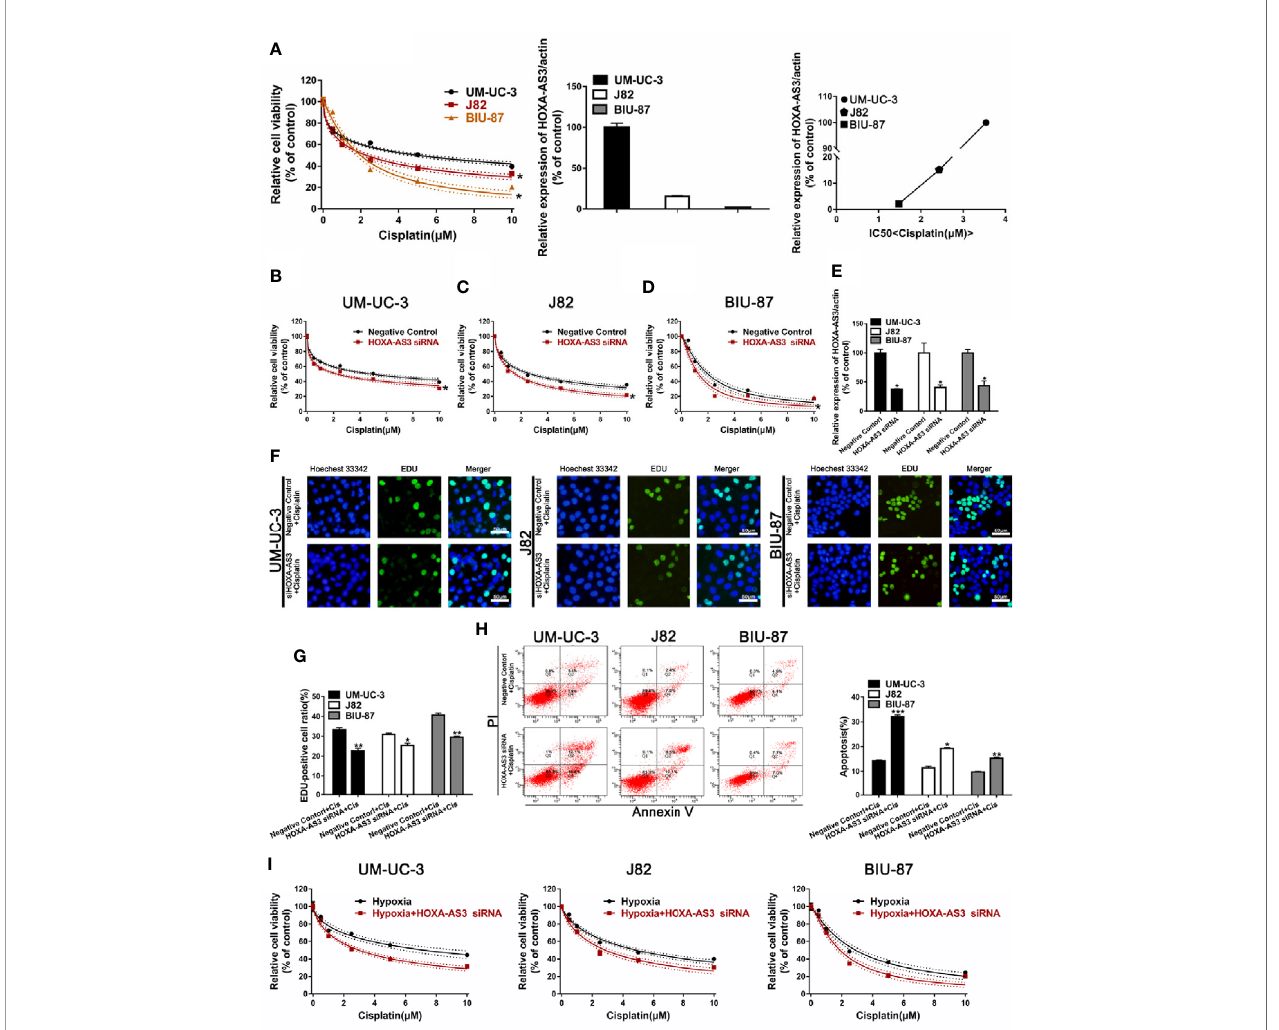
FIGURE 2 | Downregulation of HOXA-AS3 enhances cisplatin sensitivity. (A) Quantitative RT-PCR analysis of HOXA-AS3 levels in three bladder cancer cell lines. Cell viability (CCK-8) analysis of bladder cancer cells treated with various concentrations of cisplatin *P < 0.05 vs . UM-UC-3. Correlation curve showing the association of the expression of long non-coding RNA (lncRNA) HOXA-AS3 with sensitivity to cisplatin in bladder cancer (BC) cells. (B – D) Cell viability (CCK-8) analysis of bladder cancer cells transfected with HOXA-AS3 small interfering RNA (siRNA) or a negative control followed by treatment with different concentrations of cisplatin (0, 0.625, 1.25, 2.5, 5, 10 m M). *P < 0.05 vs . negative control. (E) The interference ef fi ciency of HOXA-AS3 siRNA was determined by qRT-PCR. *P < 0.05, **P < 0.01. (F , G) Photomicrographs and bar graphs depicting EdU staining and relative EdU-positive ratio in bladder cancer cells after treatment with cisplatin alone, or cisplatin combined with HOXA-AS3 siRNA. *P < 0.05, **P < 0.01. (H) The number of apoptotic cells in bladder cancer cells transfected with a negative control or HOXA-AS3 siRNA followed by cisplatin treatment, as detected by fl ow cytometry. *P < 0.05, **P < 0.01, ***P < 0.001 vs . negative control plus cisplatin. (I) Knockdown of HOXA-AS3 siRNA enhanced cisplatin sensitivity under hypoxic